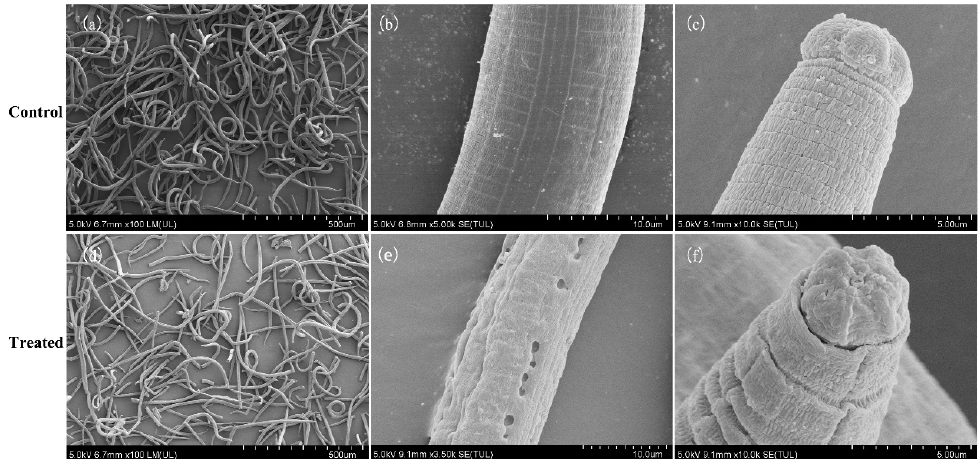
Figure 6. Observation by scanning electron microscope on morphologies of B. xylophilus treated with 0.3 mg·mL − 1 purified AMP (MaltAtt-1). ( a ) normal B. xylophilus ; ( b ) body wall of normal B. xylophilus ; ( c ) head of normal B. xylophilus ; ( d ) treated B. xylophilus ; ( e ) body wall of treated B. xylophilus ; ( f ) head of treated B. xylophilus .